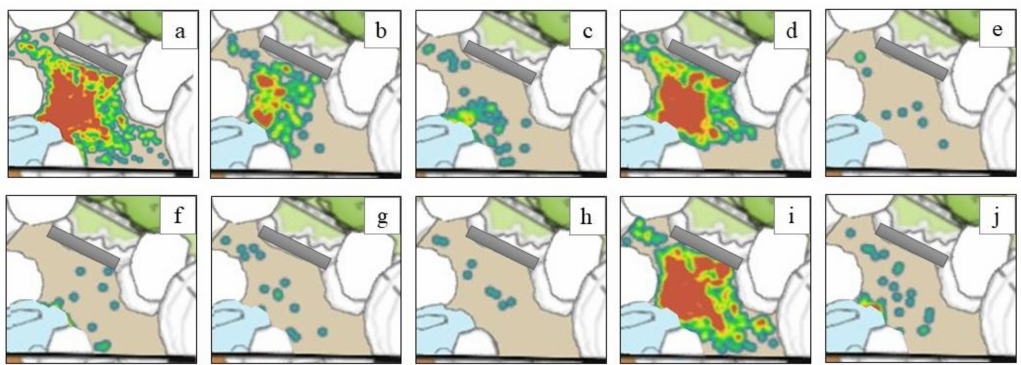
Figure 3. Space use of penguins during the encounters. These space use densities indicate the frequency with which penguins were observed at specific locations inside the encounter area, coded at 2-min intervals during encounters. A single use of a specific location is indicated in blue, and the color changes from blue to green to yellow to red as more use is coded in the same location. The grey rectangle represents the visitor bench. Data shown only for penguins who were observed in at least one encounter. ( a ) All penguin use combined, ( b ) Aje, ( c ) Dudley, ( d ) Erik, ( e ) Liam, ( f ) Mandela, ( g ) Maria, ( h ) Maynard, ( i ) Phil, and ( j )